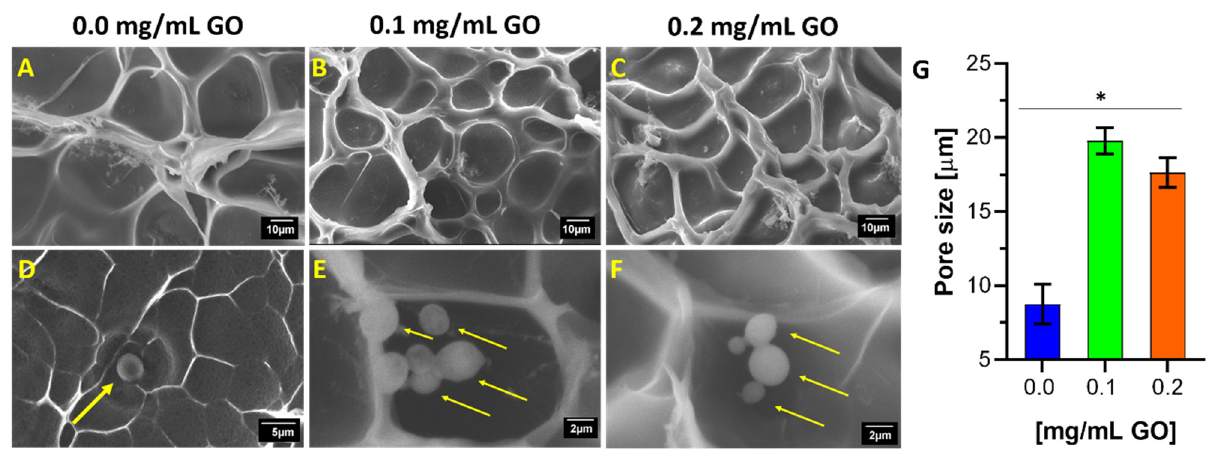
Figure 3. Surface morphology described by scanning electron microscope (SEM) micrographs of cross-linked and uncross- linked hydrogels in the presence and absence of yeast cells. First row is for 7.5% ( w / v ) gelatin and 3.0% ( w / w ) GTA concentration and varying GO concentrations from 0.0% ( A ), 0.1% ( B ) to 0.2% ( w / w ) ( C ). Second row ( D – F ) is for the same formulation but at a higher magnification. Images also include yellow arrows to point to K. lactis cells compartmentalized into the gel pores. Finally, the average pore size is shown for the treatments ( G ). *, p <0.05.